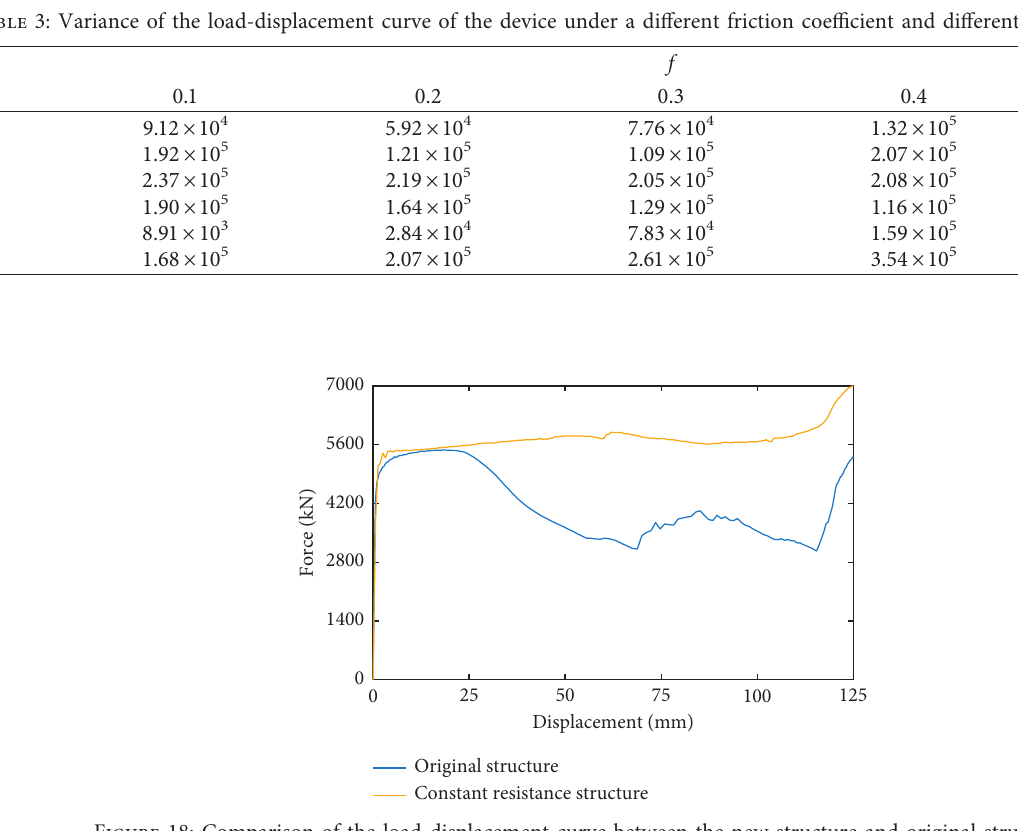
Figure 18: Comparison of the load-displacement curve between the new structure and original structure.